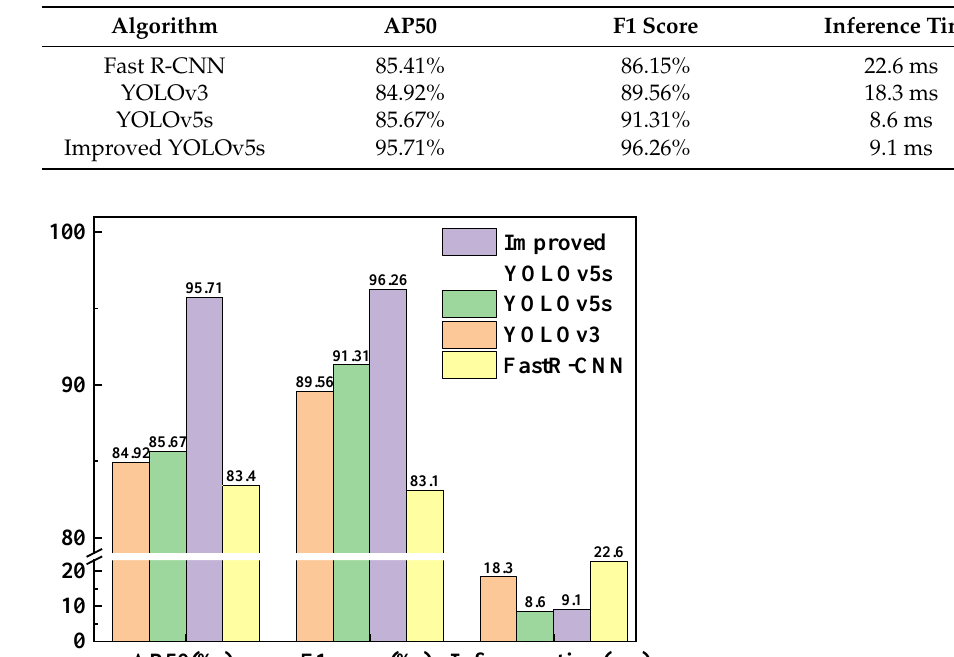
Figure 11. P–R curves for the detection models. Figure 11. P – R curves for the detection models. Figure 11. P – R curves for the detection models. Table 4. Comparison of evaluation indicators of various models. Table 4. Comparison of evaluation indicators of various models. Table 4. Comparison of evaluation indicators of various models.